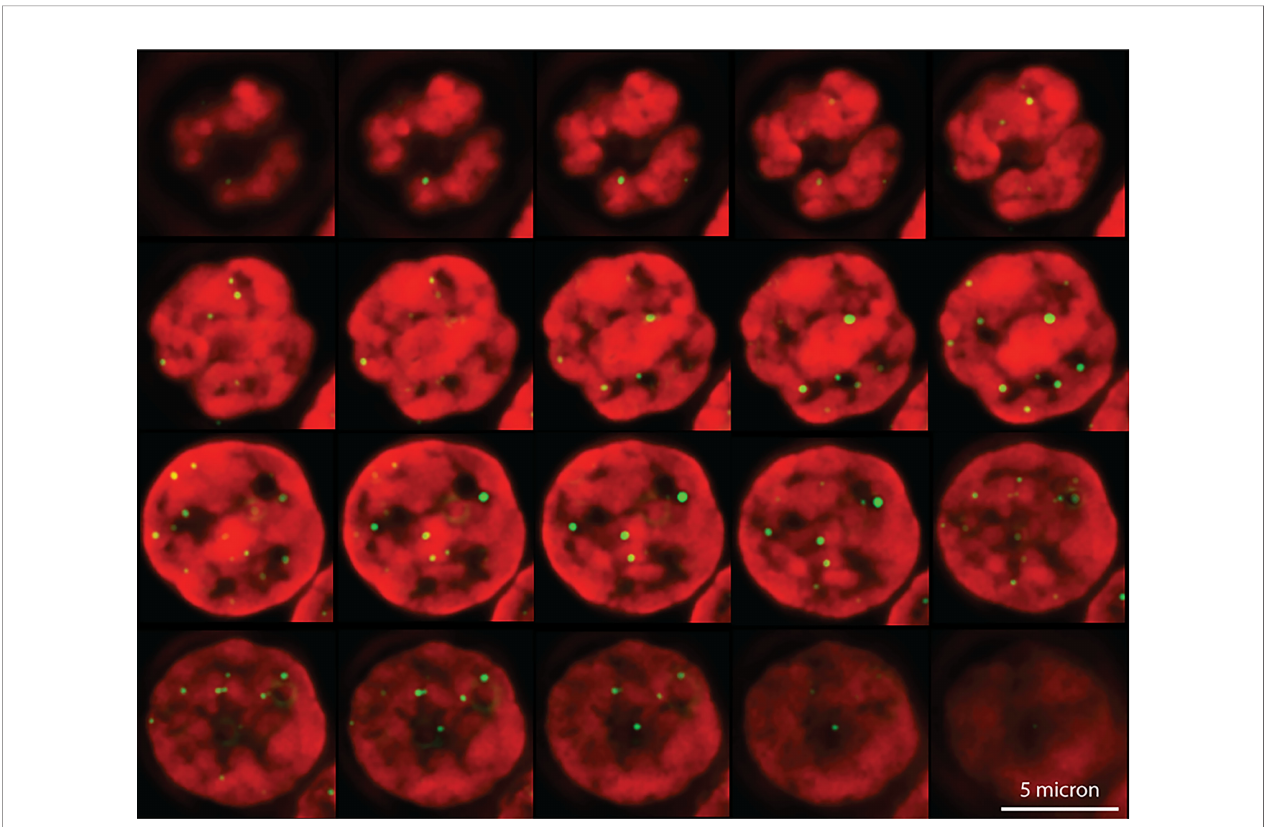
FIGURE 2 | Telomeres in a human lymphocyte are not randomly distributed in the nucleus. Shown are optical sections through the interphase nucleus of a human T lymphocyte following formaldehyde fi xation and fl uorescence in situ hybridization with fl uorescently labeled (CCCTAA) 3 PNA (shown in yellow/green). DNA is counterstained with DAPI (shown in red). A stack of images, acquired at separate focal planes, was processed using deconvolution microscopy (40). Note that telomeres appear to cluster at the interface between DNA bright areas, presumably re fl ecting heterochromatin and DNA weakly stained areas, presumably representing euchromatin (Chavez and Lansdorp unpublished